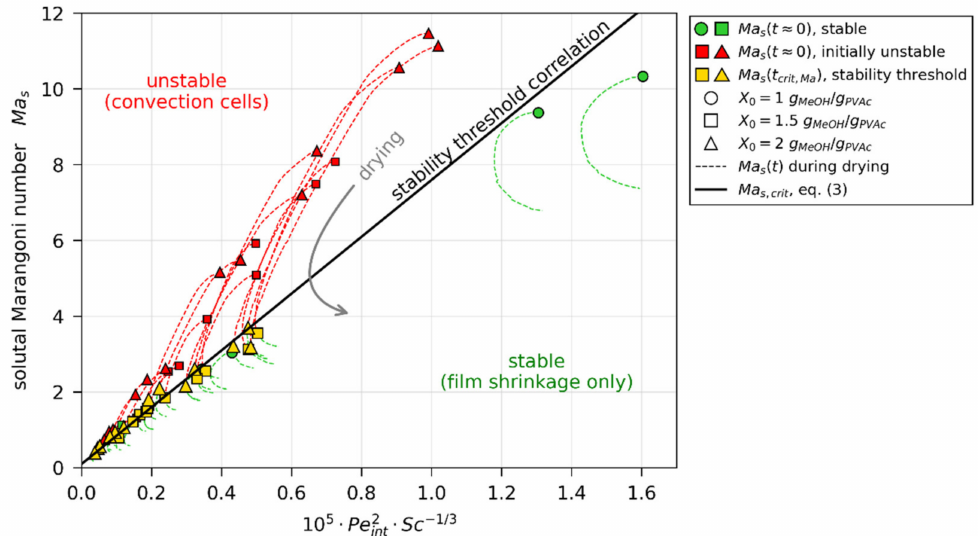
Figure 12. Solutal Marangoni numbers, calculated from simulations matched to µ PTV experiments, as function of condensed parameter comprising P é clet and Schmidt numbers. The dashed lines indicate transient Ma s values for all µ PTV experiments, starting at green (stable) or red (initially convectively unstable) markers, respectively.